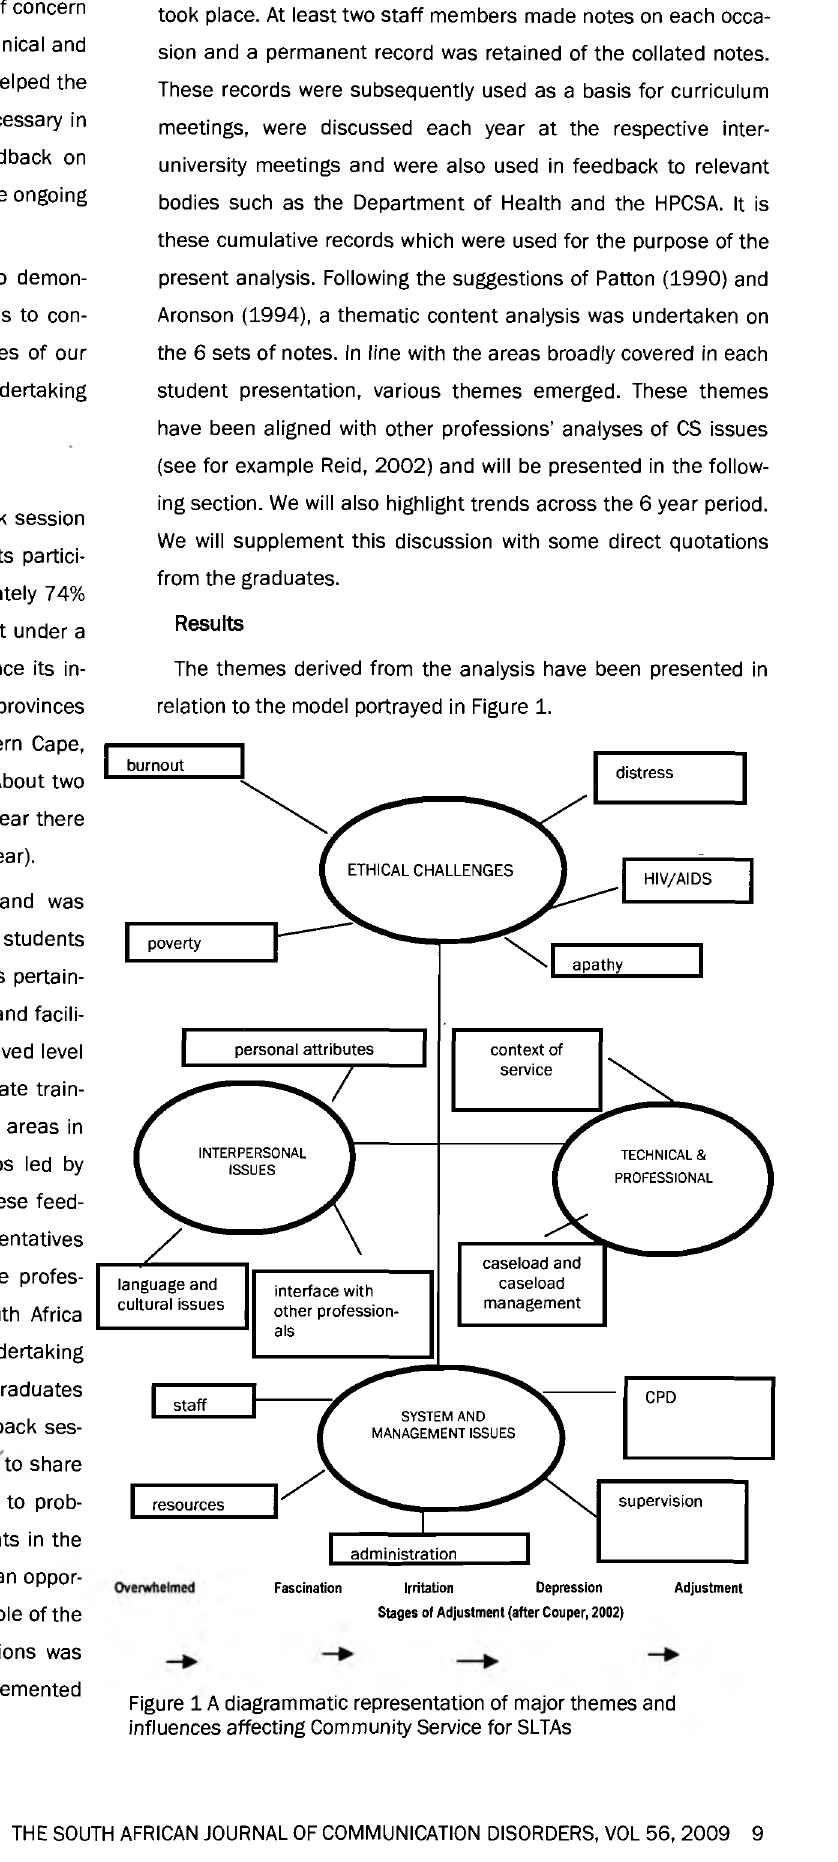
THE SOUTH AFRICAN JOURNAL OF COMMUNICATION DISORDERS, VOL 56, 2009